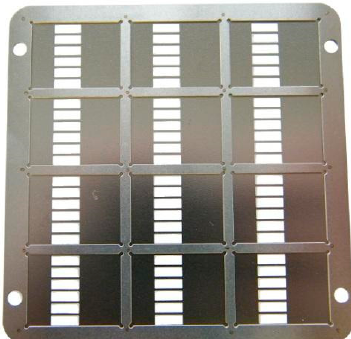
Figure 15. Mask purchased from Ossila used to create the cathode pattern during the deposition of Ag via vacuum thermal evaporation (VTE). Image remains the copyright of Ossila Ltd. Taken with permission from Ossila Ltd. [29].